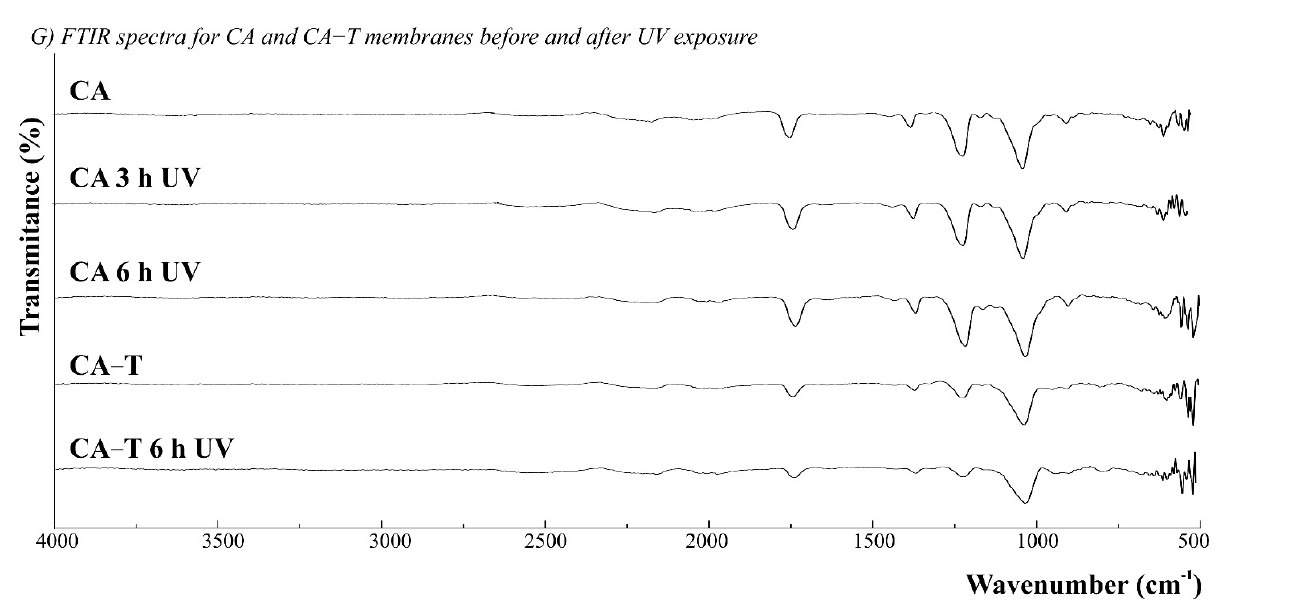
Figure 7. ( A – D ) SEM images for CA (cellulose acetate) and CA-T (CA modified with TiO 2 ) membranes before and after UV exposure (magnification ×3000), ( E ) CA-T EDS, ( F ) EDS mapping showing the Ti distribution on the membrane surface after 6 h UV exposure, and ( G ) Fourier transform infrared spectroscopy (FTIR) spectra for CA and CA-T membranes before and after 3 and 6 h of UV